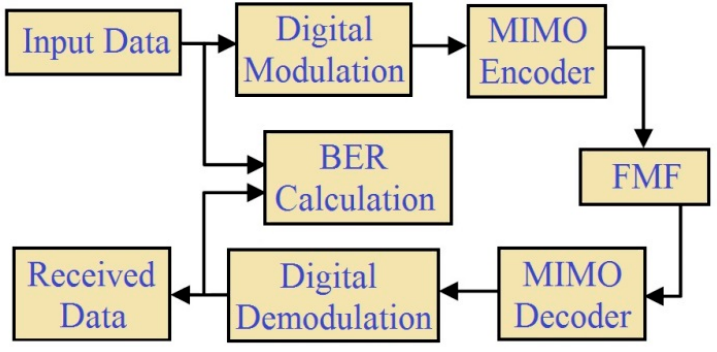
Figure 6. Schematic of an MDM system utilizing the MIMO FDE [31].